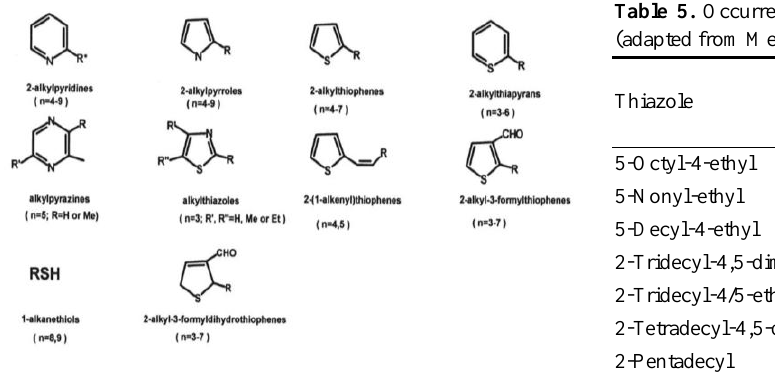
Figure 6. Volatile compounds of lipid-Maillard interaction (Melton,